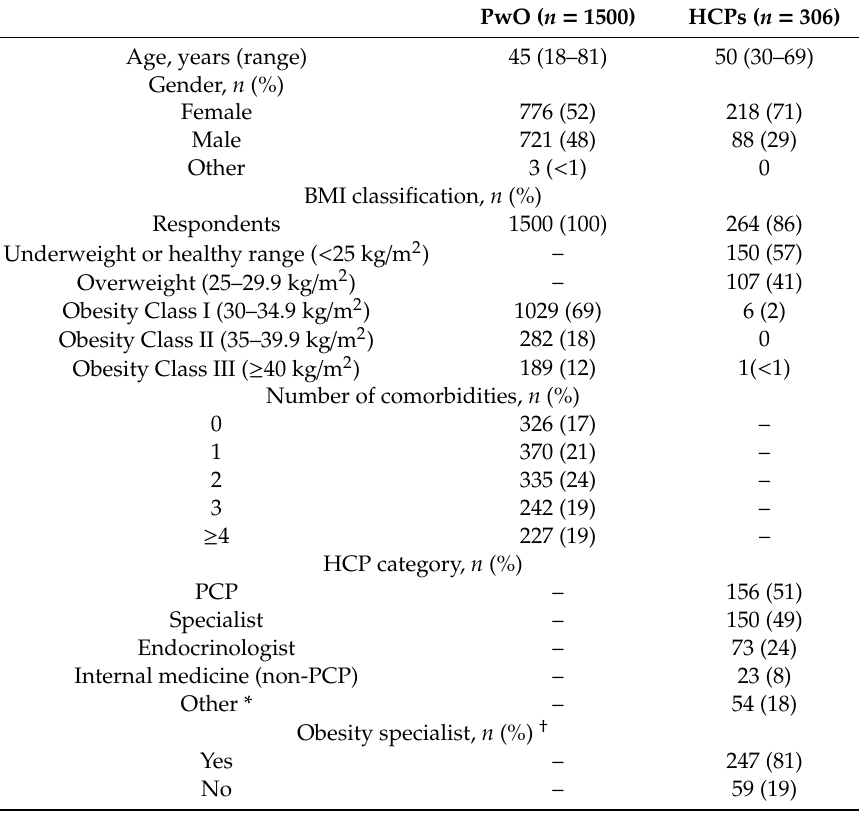
Table 2. Sample demographics and